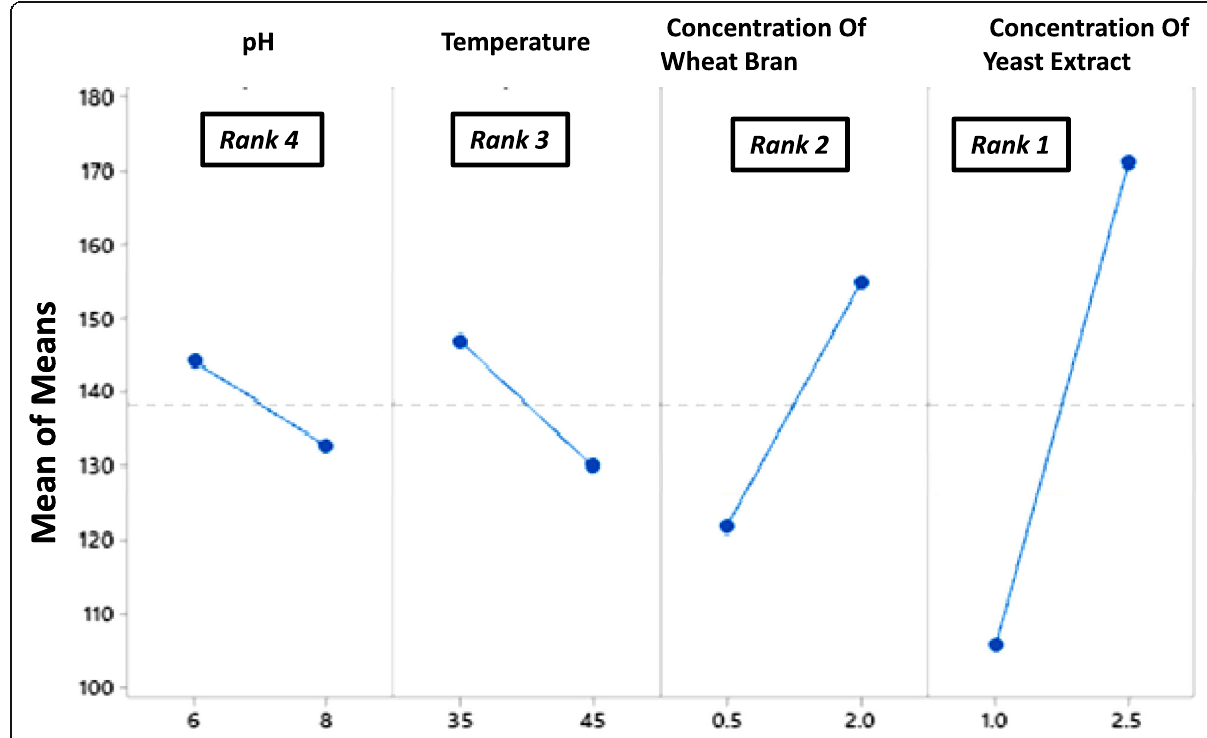
Fig. 6 Main effects plot for data means obtained in the optimization trial runs